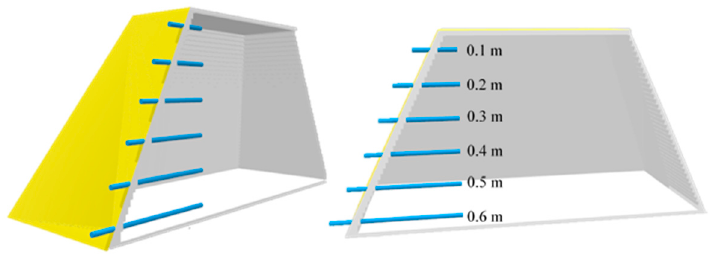
Figure 1. Location of the tubes inside the piles to carry out the determination of O 2 and CO 2 .